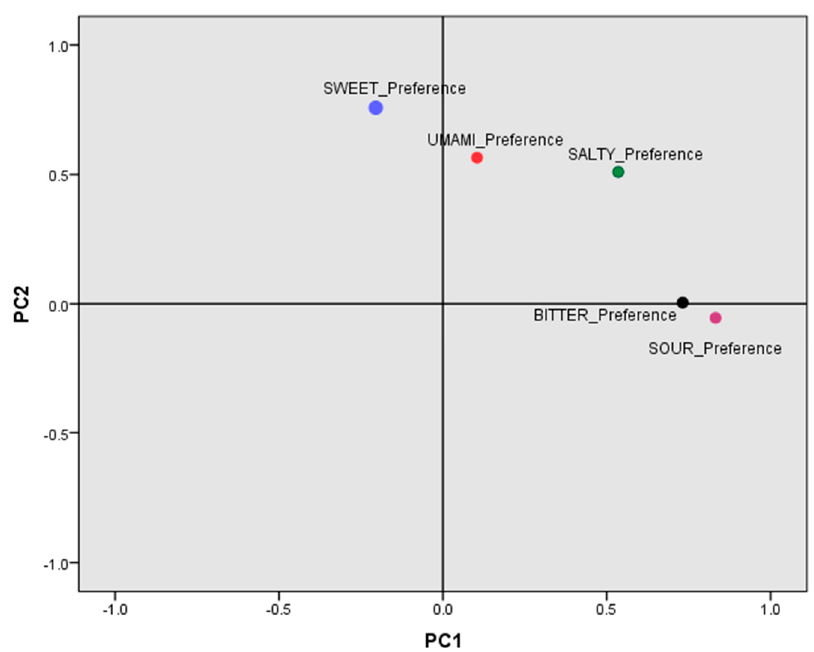
Figure 1. Principal component analysis loading plots for the rotated (varimax rotation) components. Taste preference analysis for sweet, salty, sour, umami and bitter. PC1 (principal component 1), PC2 (principal component 2). Data obtained from a factor analysis including the five taste preference variables ( n = 425 subjects).